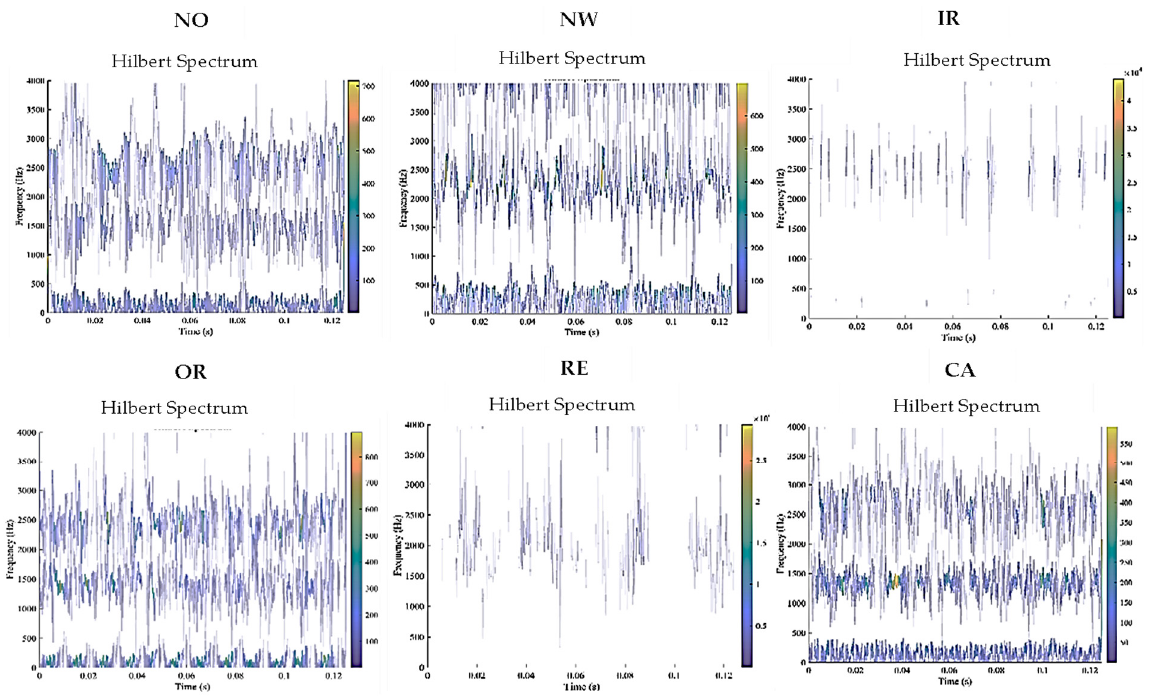
Figure 23. Examples of the produced Hilbert spectrums using HHT with VMD from bearing vibration signals with six health conditions that were described in Section 2.1.1 above.